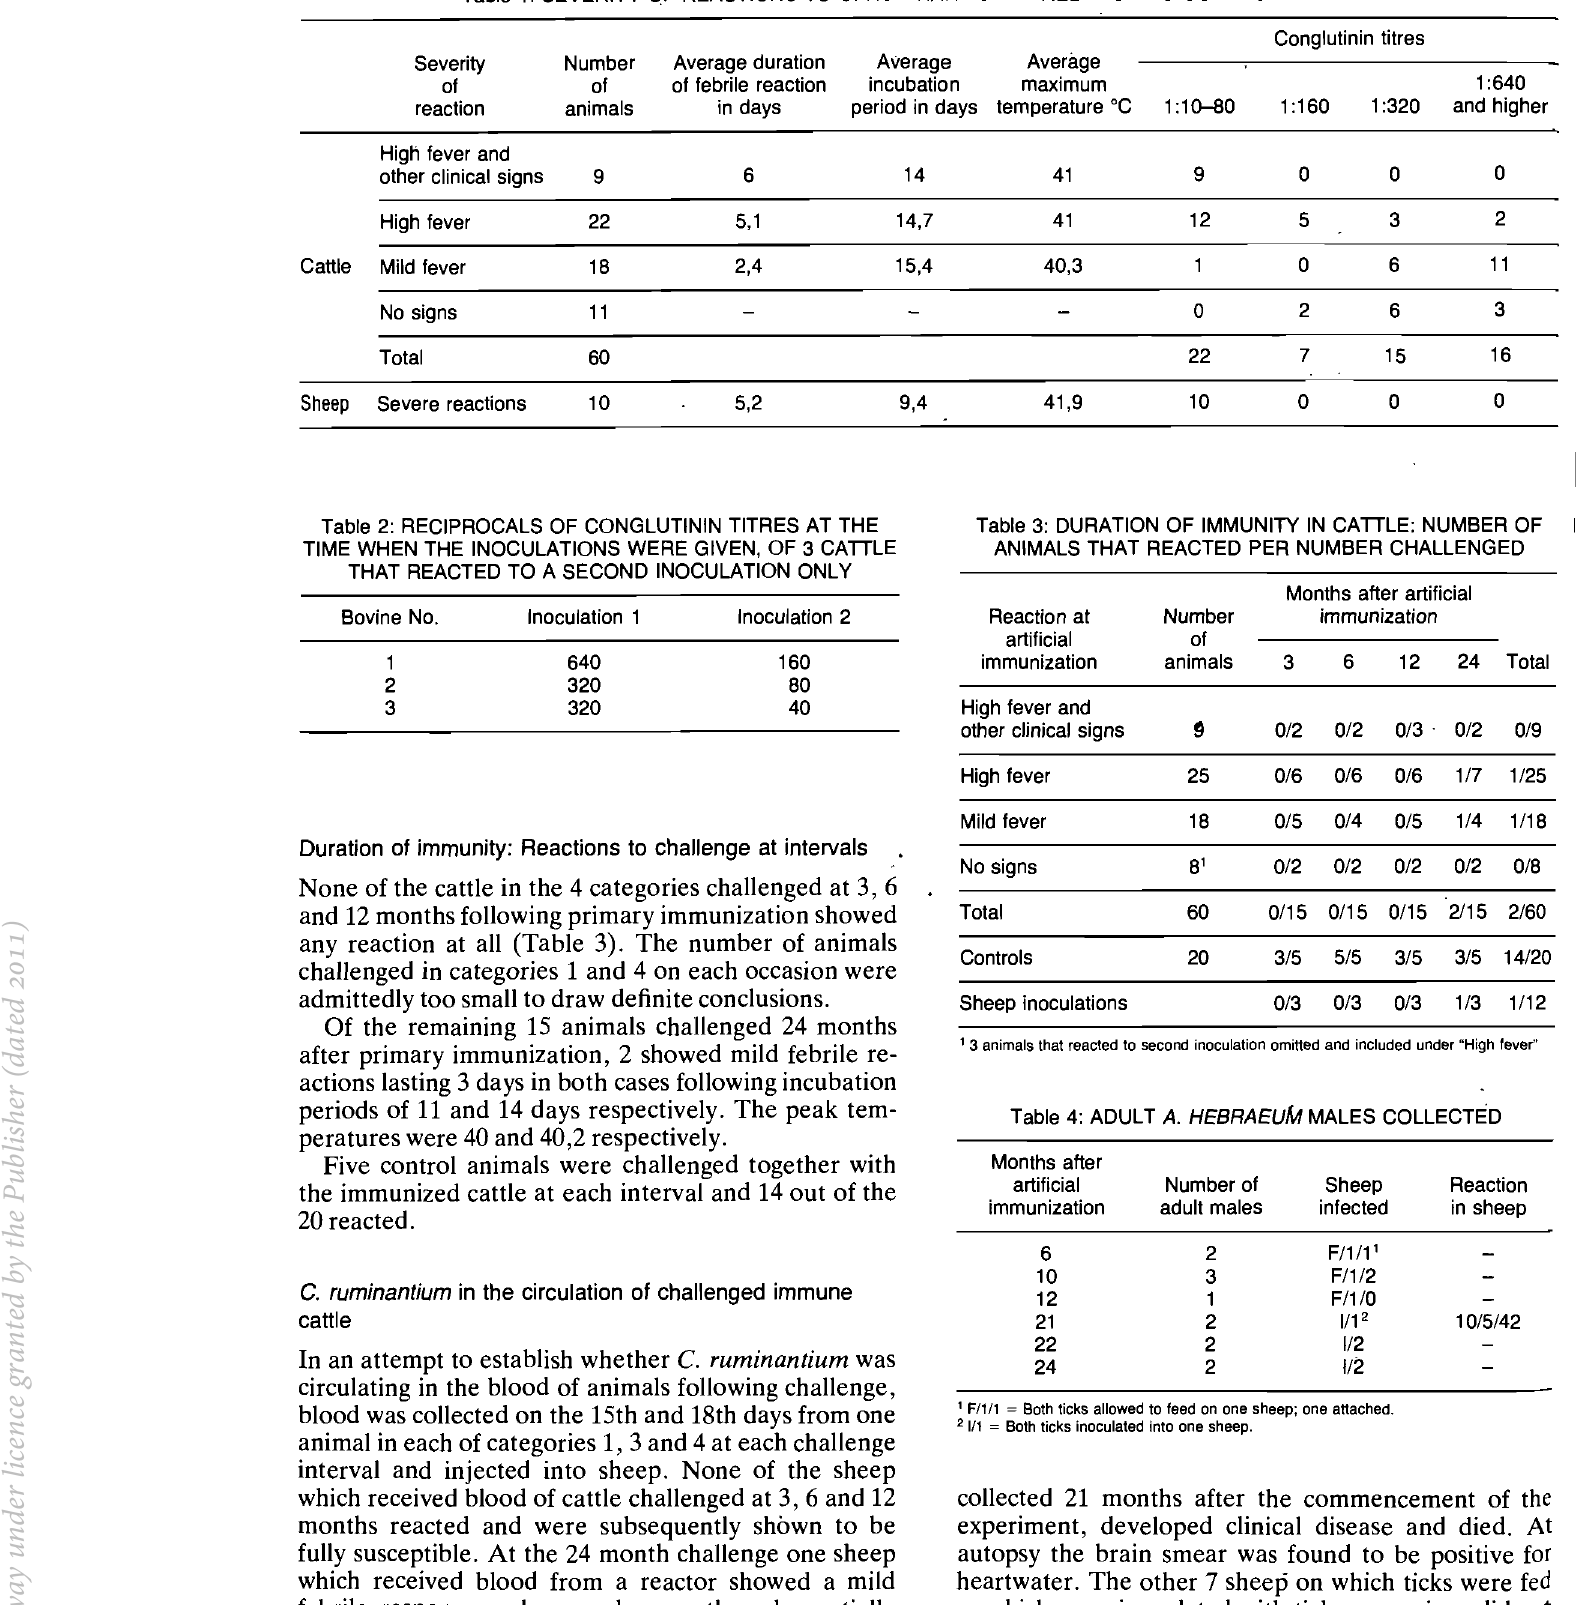
Table 1: SEVERITY OF REACTIONS TO C. RUMINANTIUM IN RELATION TO CONGLUTININ TITRES